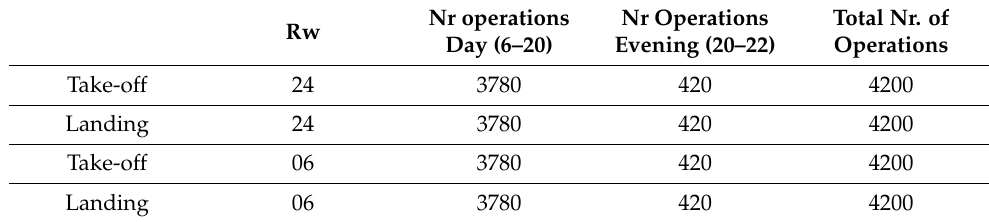
Table 7. ATR42-500 annual traffic scenario.